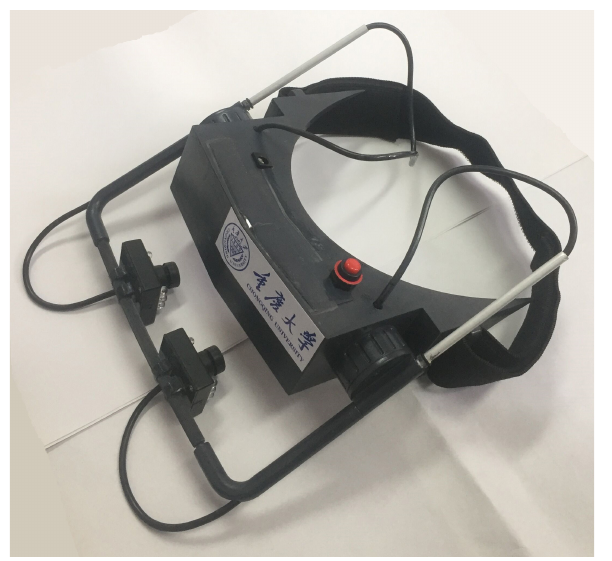
FIGURE 1 | The eye tracker in our